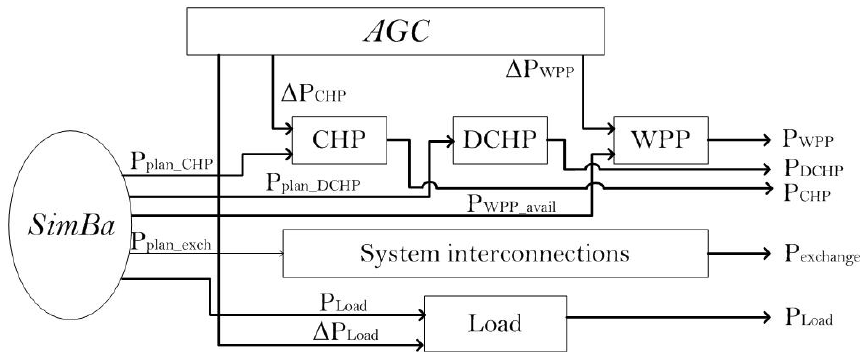
Figure 1. Power system